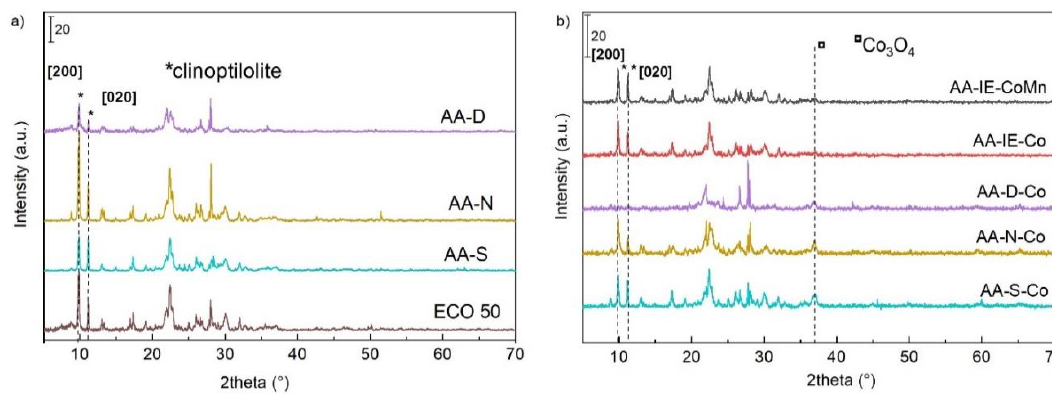
Figure 4. Powder di ff raction patterns of supports ( a ) and fresh catalysts ( b Figure 4. Powder diffraction patterns of supports ( a ) and fresh catalysts ( b ).